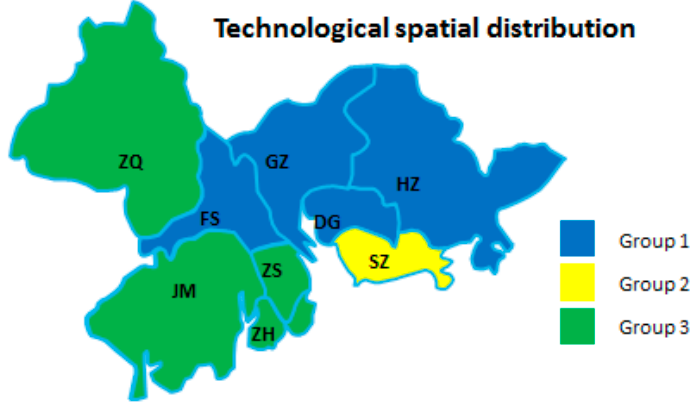
Figure 5. Technological spatial distribution of the nine cities.